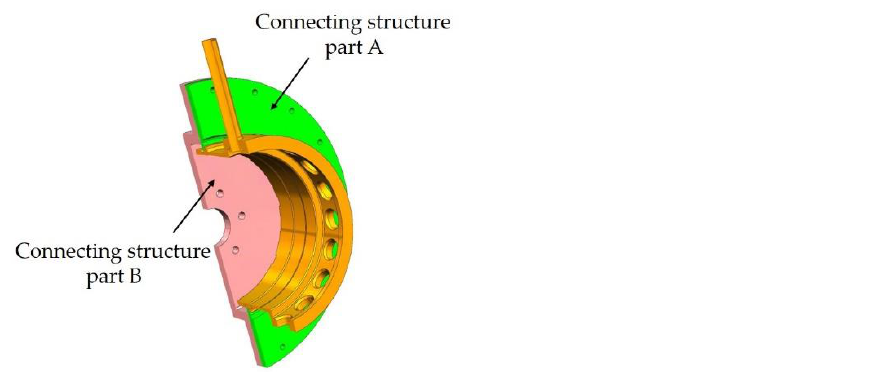
Figure 7. Schematic diagram of the vortex reducer and its connecting structure.